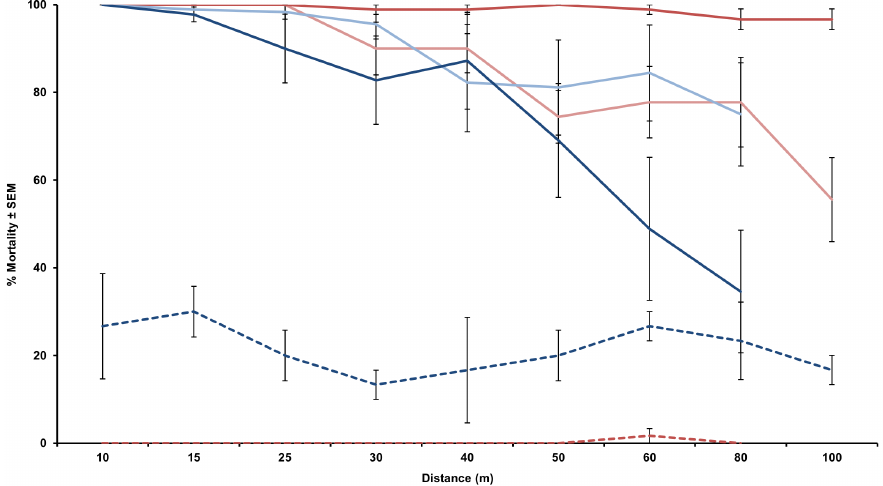
Figure 1. Aedesalbopictus 72 hr mortality rates for VectoBac WDG applied with a CSM2 and LV-8 at 400 and 800 g/ha in an open- field. Red=CSM2, blue=LV-8, light colors=400 g/ha, dark colors=800 g/ha, dashed